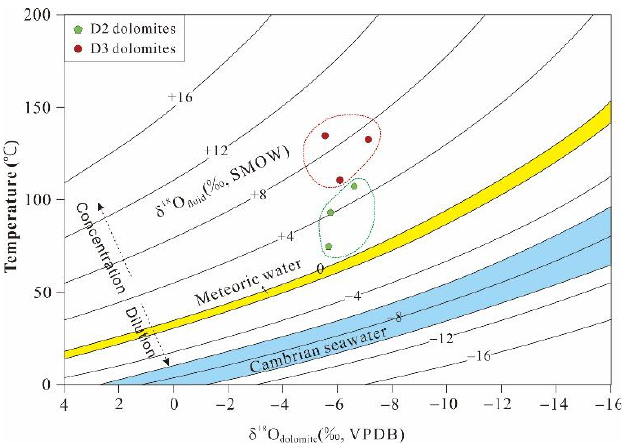
Figure 11. Cross-plot of δ 18 O values (VPDB) versus homogenization temperatures of D2 and D3 dolomites. Curved lines are isopleths for δ 18 O fluid calculated using the dolomite – fluid oxygen isotope fractionation equations [5].